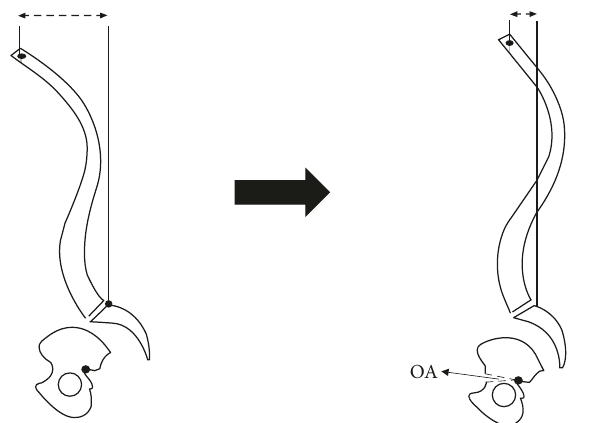
Figure 1: Schematic representation of the sagittal view of the spinopelvis system showing proposed bilateral pelvic osteotomy (BPO) procedure. Osteotomy will be performed caudal to SIJ but above the hip joints. A small change in pelvis opening angle (OA) will result in considerable sagittal vertical axis (SVA)